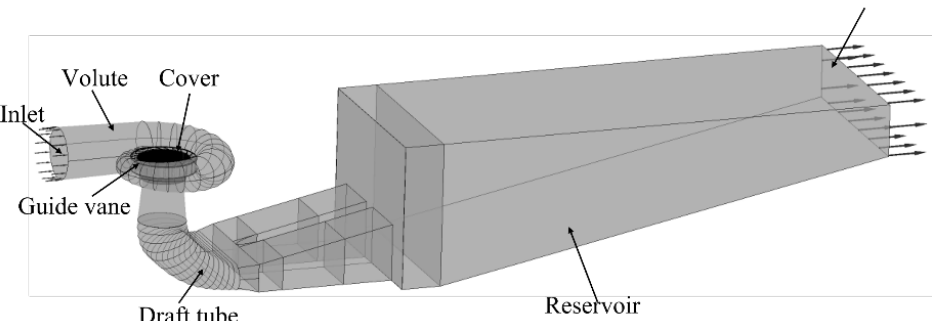
Figure 1. Model of numerical simulation.